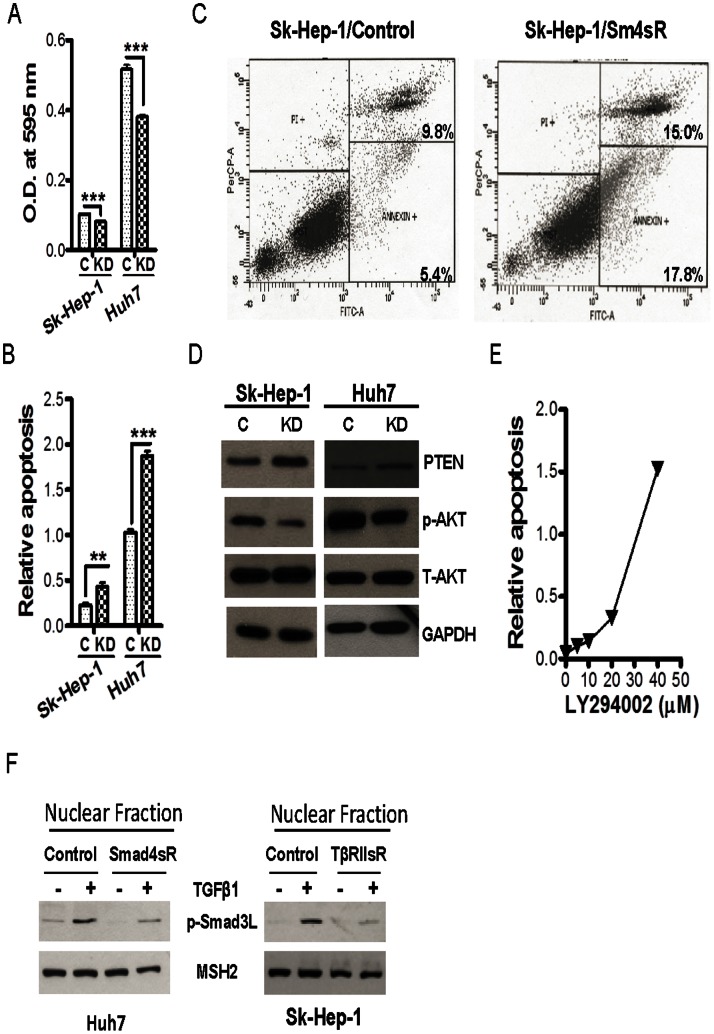
Reduced growth and increased apoptosis in HCC cells with Smad4 knockdown.(A) MTT assay for Sk-Hep-1 and Huh7 cells with control and Smad4 shRNA. **, p<0.01; ***, p<.001. (B) Apoptosis assay was performed in SK-Hep-1 and Huh7 cells with or without Smad4 shRNA using the Cell Death Detection ELISA. Each data point represents mean±SEM from three independent wells. **, p<0.01, ***, p<0.001. (C) Cell apoptosis was assessed in Sk-Hep-1 cell with or without Smad4 shRNA with Annexin-V FITC Apoptosis Kit. The cells in the lower right quarter are Annexin-V positive apoptotic cells as expressed with the percentage. (D) Immunoblotting analysis for indicated proteins in Sk-Hep-1 and Huh7 cells with or without Smad4 shRNA. (E) Cells were plated in a 6-well plate and treated with various concentrations of LY294002 for 24 hours when the culture was 70–80% confluence. Each data point represents mean ±SEM from three independent wells. (F) Immunoblotting analysis of P-Smad3L in the nuclei of Sk-Hep-1 and Huh7 with or without TβRII shRNA or Smad4 shRNA after treatment with TGF-β1 at 2 ng/ml for 1 hr.